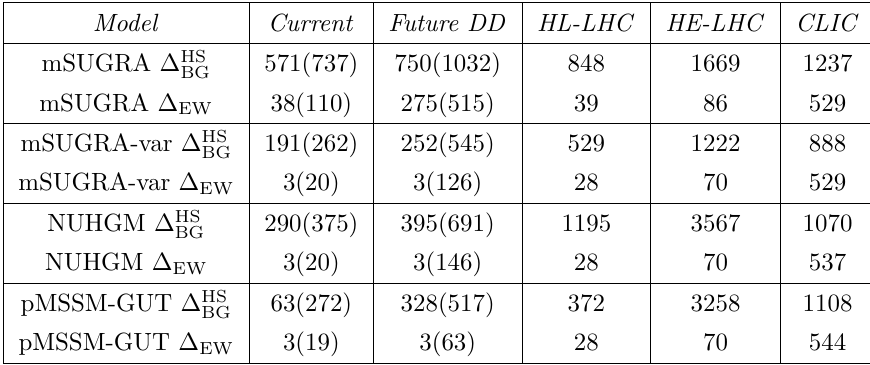
Table 2 . Summary of the high-scale models and their minimal amount of FT (rounded to integers). The (cid:12)rst column indicates the high-scale model (de(cid:12)nitions can be found in section 2.1). The second column shows the minimal FT both for (cid:1) HS and (cid:1) EW after applying only the current constraints. BG Between brackets we quote the result for the spectra that result in 0 : 09 < (cid:10) h 2 < 0 : 15. The third column gives the minimum of (cid:1) HS and (cid:1) EW after all the future DMDD experiments. The BG remaining columns give the maximal constraining power on (cid:1) HS and (cid:1) EW using the reach of the BG HL-LHC, HE-LHC and